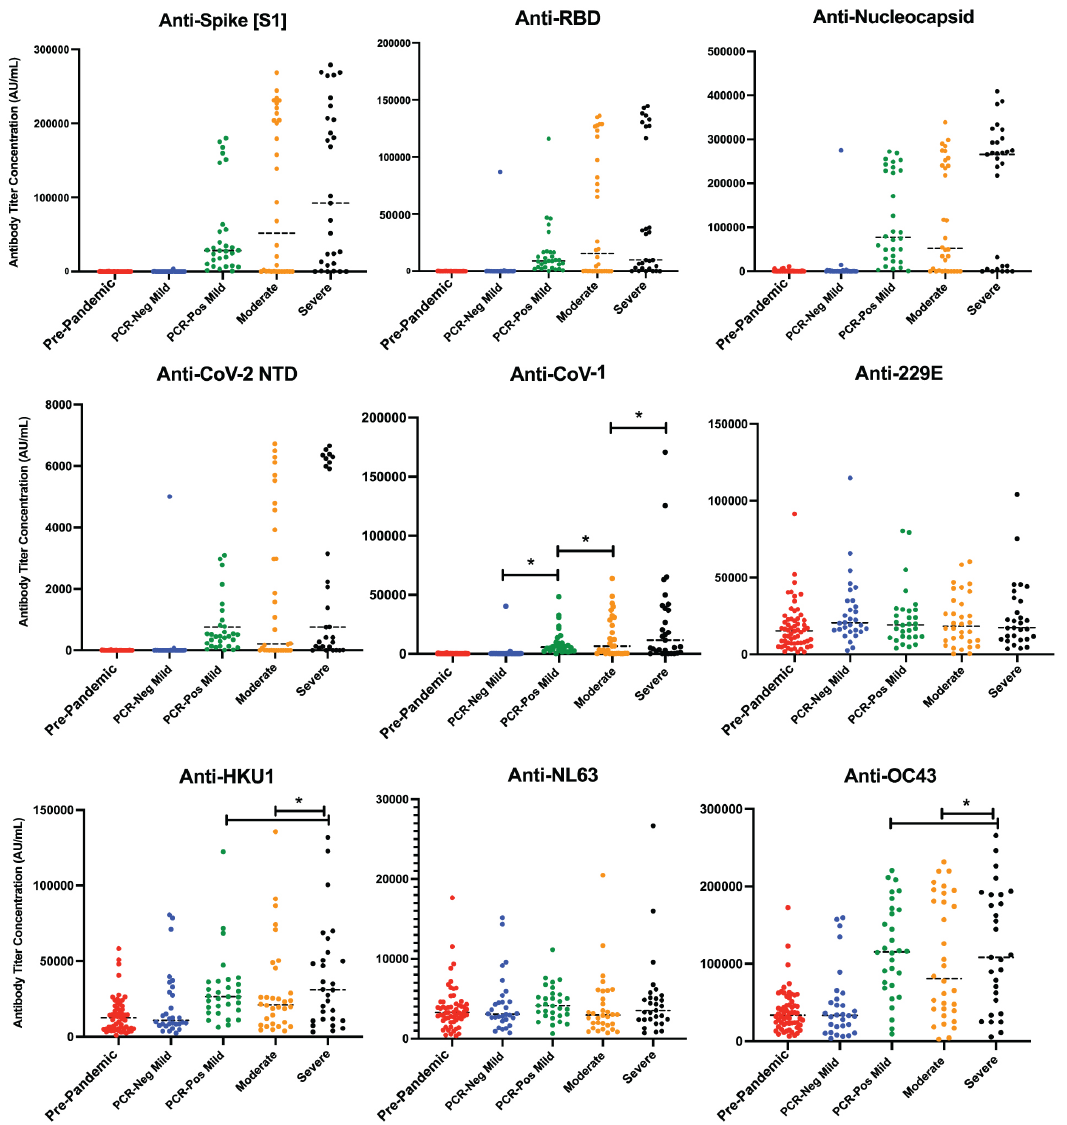
Figure 1. Quantitative antibody response by disease severity . Dot plot representation of SARS-CoV-2 antibody concentration against spike (A), RBD (B), nucleocapsid (C), and N-terminal Domain of the nucleoprotein (NTD, D) across disease cohorts. Dot plot representation of samples for antibody cross- reactivity against the spike protein of SARS-CoV-1 (E), along with other alpha and beta coronaviruses (F-I) across disease severity. A static cutoff of 1000 AU/mL (anti-spike), 800 AU/mL (anti-RBD), and 5000 AU/mL (anti-N), depicted by the gray dashed line, was used to determine positive antibody response. SARS-CoV-2 PCR-positive mild, moderate, and severe disease cohorts had increased antibody titers against CoV-1, with increasing antibody concentration by increased disease severity ( P < 0.001). HKU1 and OC43 anti-S concentrations were statistically significantly increased in severe disease groups, compared to mild and moderate disease groups ( P < 0.001). *: P <